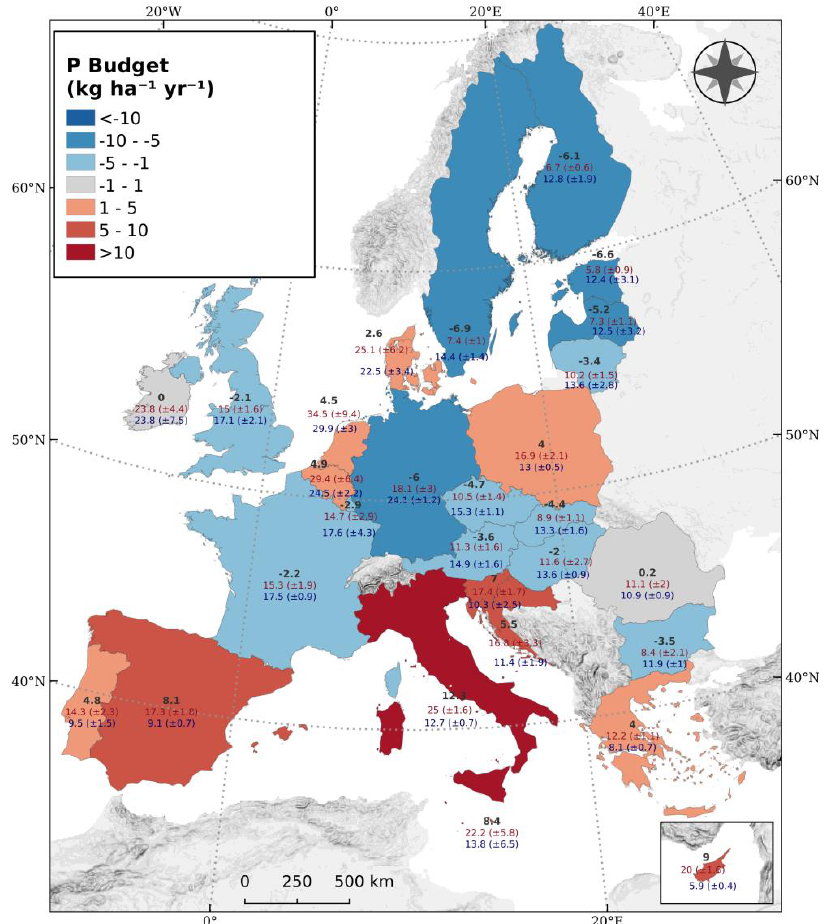
Figure 12. Phosphorus budget at country scale including sum of inputs/outputs and uncertainties [43].